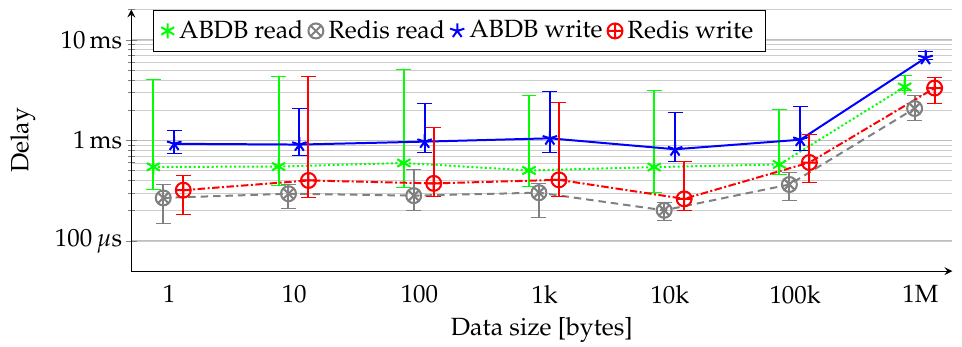
Figure 5. Data access latency of functions deployed to an edge node where an ABDB child and a Redis server are both available. Maximum, average and minimum values are